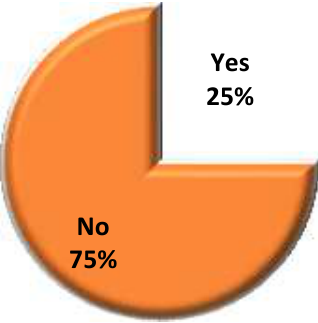
Figure 5. Existence of Local Wisdom (Source: Research Data, 2019)